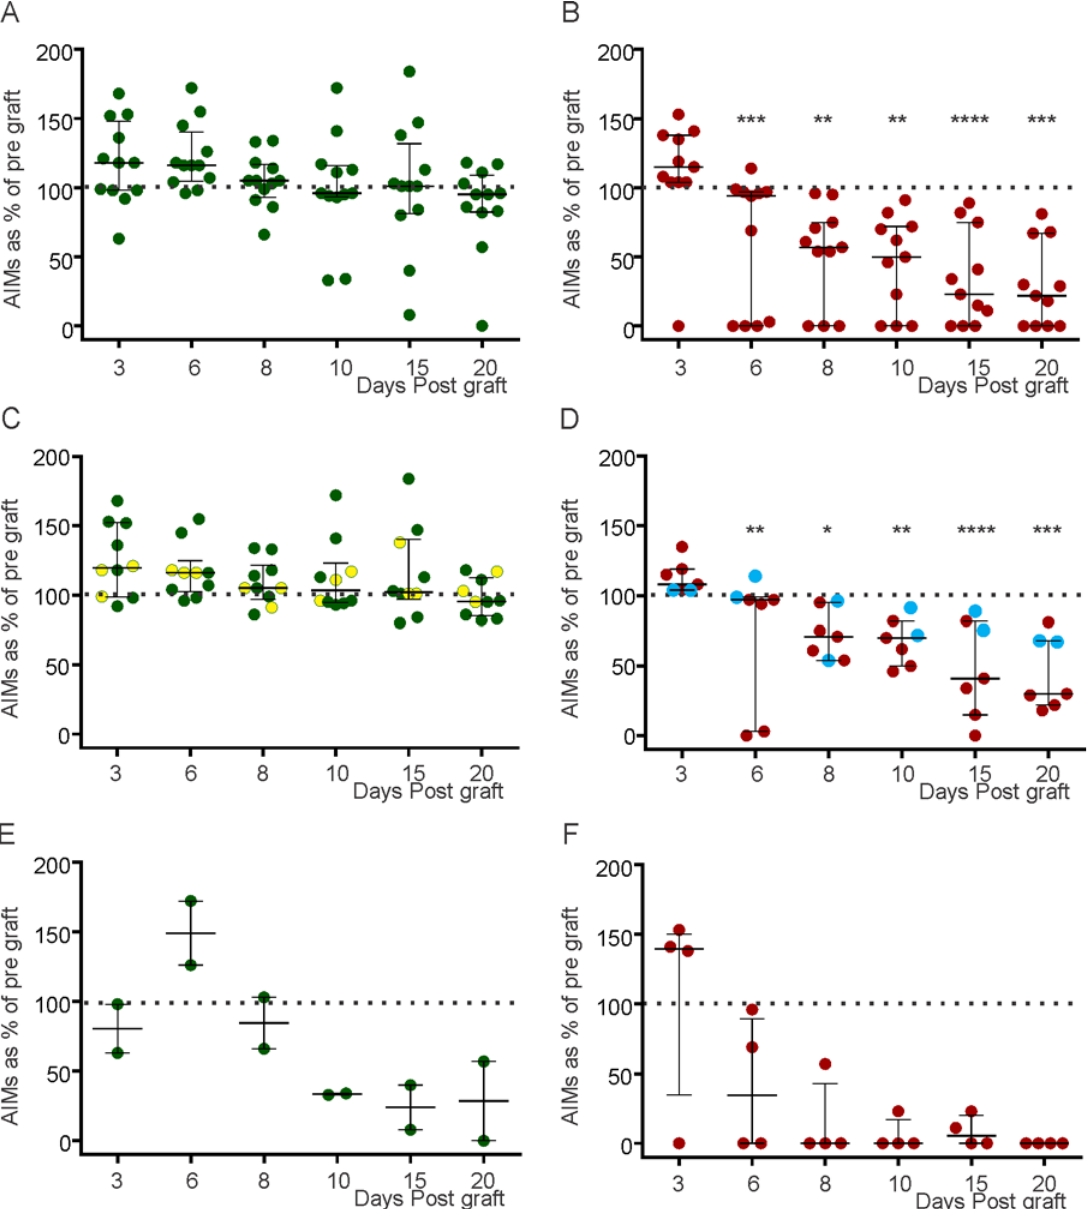
Fig 3. The percent change in AIMS (from pre-graft levels at various days post graft. In all figures, the y axis shows percent change in AIMS from pre- graft levels at various days post graft (x axis), bars show median and interquartile range and the statistical tests are ANOVA and Dunnet ’ s multiple comparisons tests where * , ** and *** indicate p < 0.05, < 0.01 and < 0.001 respectively. (A) High and low dyskinetic animals that received Null grafts or “ failed grafts. There was no significant difference between pre-graft AIMS and AIMS on any day post graft. (B) Highly and low dyskinetic animals that received a DAT graft. There was a significant difference between pre-graft AIMS at all days post-graft except day 3. (C) Animals with high AIMS (high dyskinesia group) that received a Null graft. The yellow circles represent the three “ failed grafts ” that were not included in calculations of significance. Note that one data point (243% on Day 3) is not shown. (D) Animals with high AIMS (high dyskinesia group) that received a DAT graft. The blue circles represent two animals with “ eccentric grafts ” . Note a steady and progressive fall of the median levels over the 20 days. (E) Animals with low AIMS (low dyskinesia group) that received a Null graft. Note the rapid recovery of AIMS plateauing at ~30% of pre-graft levels by day 10. (F) Animals with low AIMS (low dyskinesia group) that received a DAT graft. Note the rapid recovery of AIMS with median levels at 0% of pre-graft levels by day 8.